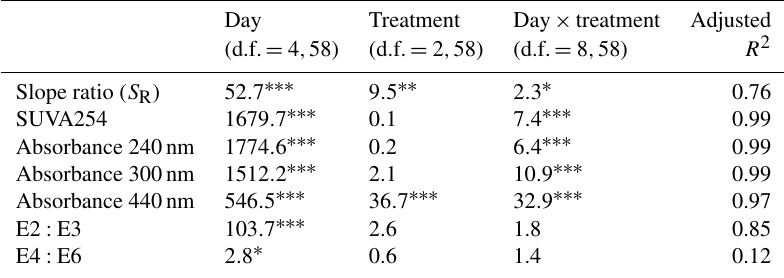
Table 2. Analyses of DOM spectral properties, with ANOVA values for each of the DOM spectral indices. Each row represents a different index. Each column indicates the F ratio for the corresponding term in a two-way factorial ANOVA model. Numerator and denominator degrees of freedom are given for each column. Within a row, larger values indicate relatively larger effects. Asterisks indicate significance levels.